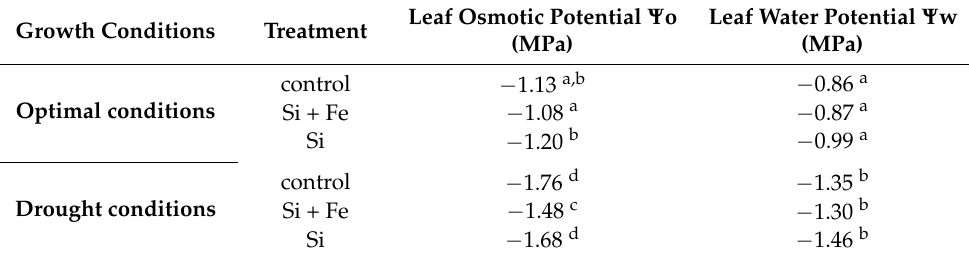
Table 4. Leaf osmotic ( Ψ o) and water ( Ψ w) potential in leaves of oilseed